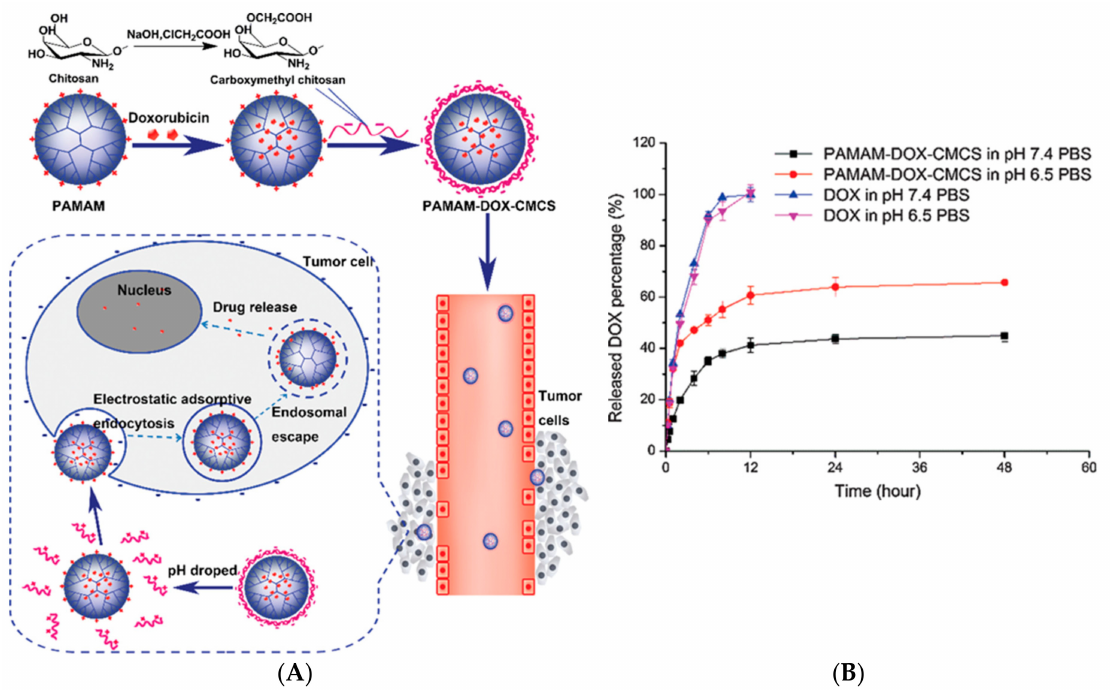
Figure 3. ( A ) Schematic representation of electrostatic conjugation of PAMAM dendrimers with carboxymethyl chitosan (CMCS) and the PAMAM-Doxorubicin-CMCS complex circulation through bloodstream and tumor microenvironment. ( B ) In vitro doxorubicin release with and